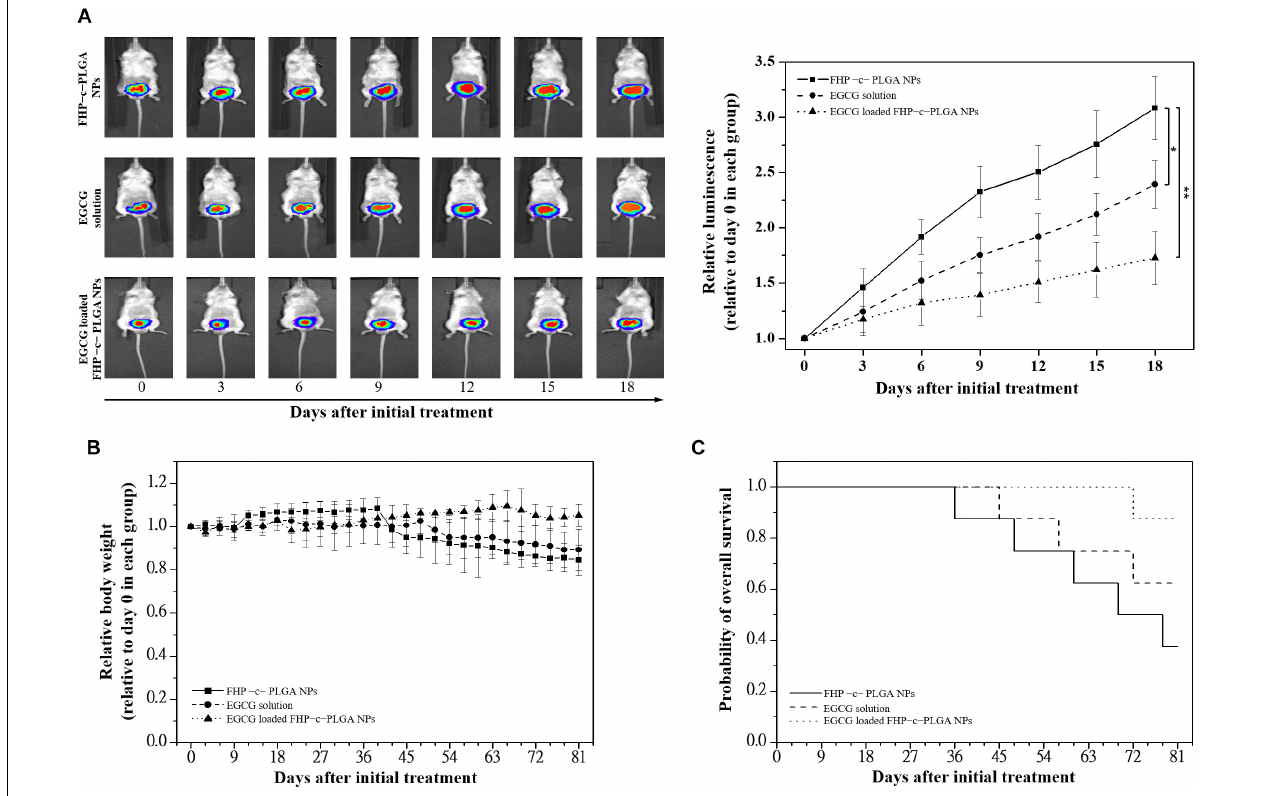
FIGURE 7 | Antitumor effects of epigallocatechin gallate (EGCG)-loaded FHP–c–PLGA NPs in orthotopic Luc prostate cancer cells (PC3) xenograft mice models. Mice were divided into three groups of six mice and were treated with only FHP–c–PLGA NPs ( (cid:4) ), EGCG solution ( 3 days for 21 days. (A) Antitumor activities using a noninvasive in vivo imaging system. Asterisk *, ** represents statistically significant difference of p -value < 0.05, and p -value < 0.01, respectively. (B) Changes in relative body weight. (C) Kaplan–Meier survival curves of mice bearing orthotopic Luc-PC3 xenografts.